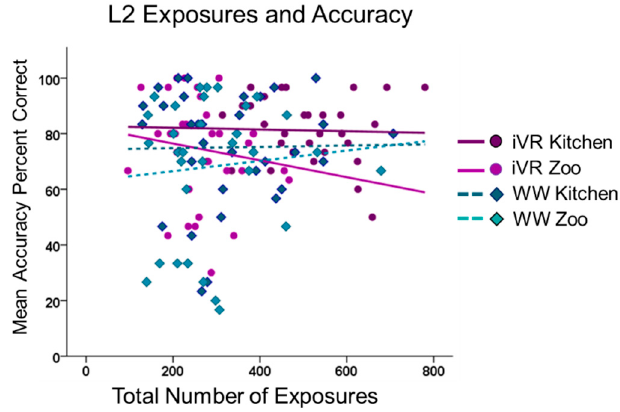
Figure 7. The relationship between L2 exposures and L2 accuracy varied by L2 learning context.